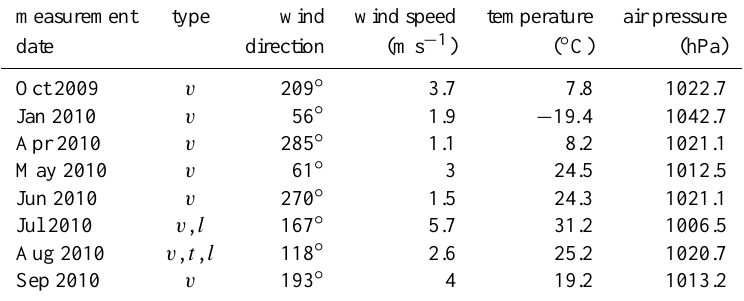
Table 1. Overview of the meteorological conditions on the days when VOC vertical profile sampling was conducted. All values are reported as hourly averages during the time of measurements and refer to the top of the measurement tower at 20m. The type of measurement conducted refers as follows v =volatile sampling, t =temperature measured on all heights, l =light measured on all heights. The sampling was in all cases conducted under clear sky